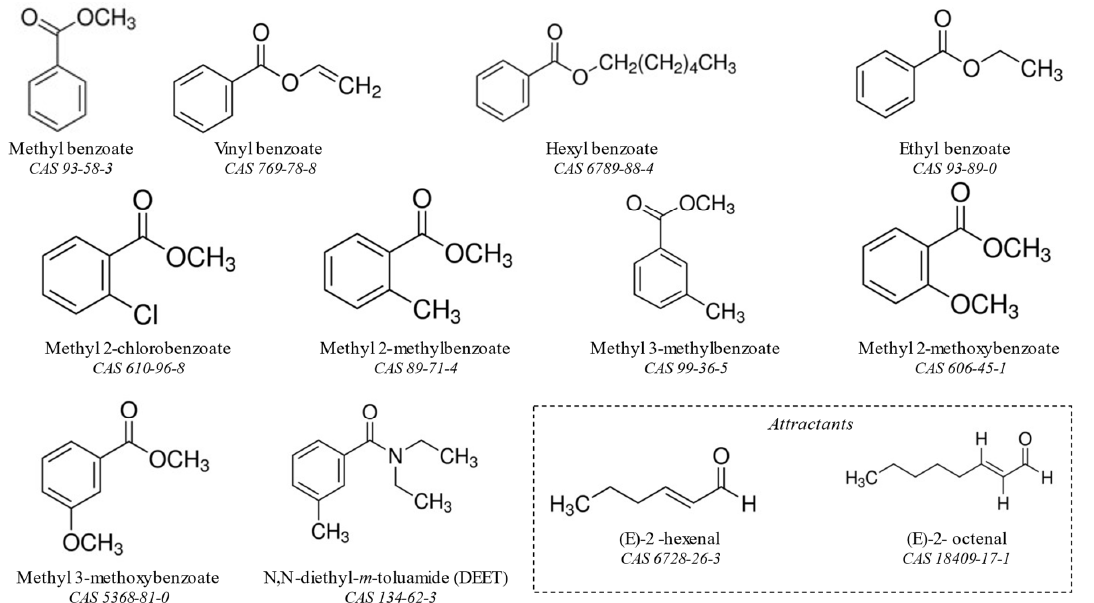
Figure 1. Chemical structure and CAS registry numbers of all compounds tested in this set of experiments. Methyl benzoate (MB), vinyl benzoate (VB), hexyl benzoate (HB), ethyl benzoate (EB), methyl 2-chlorobenzoate (M2CB), methyl 2-methylbenzoate (M2MB), methyl 3-methylbenzoate (M3MB), methyl 2-methoxybenzoate (M2MOB), methyl 3-methoxybenzoate (M3MOB), N , N -diethyl- m -toluamide (DEET), ( E )-2-hexenal, and ( E )-2-octenal.